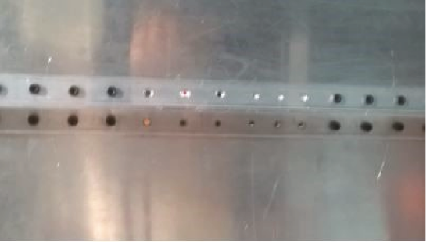
Figure 6: Detail of D3 damage.